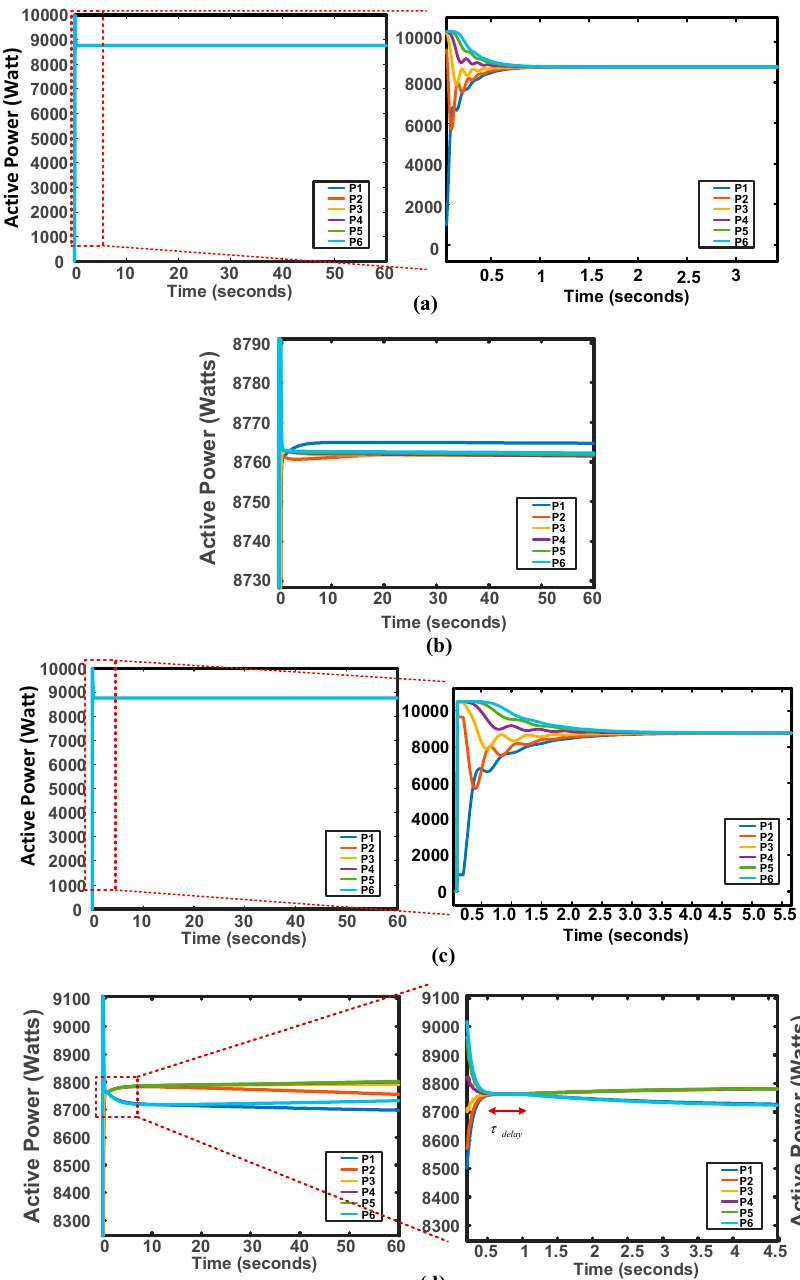
Figure 7. Active power sharing results: ( a ) Power sharing with proposed method and no link latencies ( b ) Power sharing with consensus-based control and no link latencies ( c ) Power sharing with proposed control having link latencies ( d ) Power sharing with consensus-based control having link latencies.